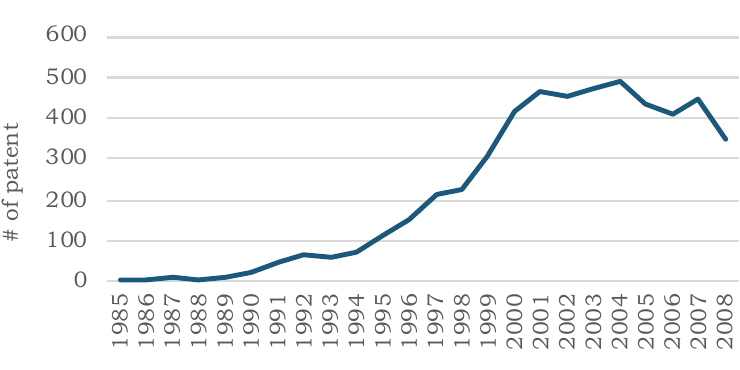
Figure 4. Transition of design-related